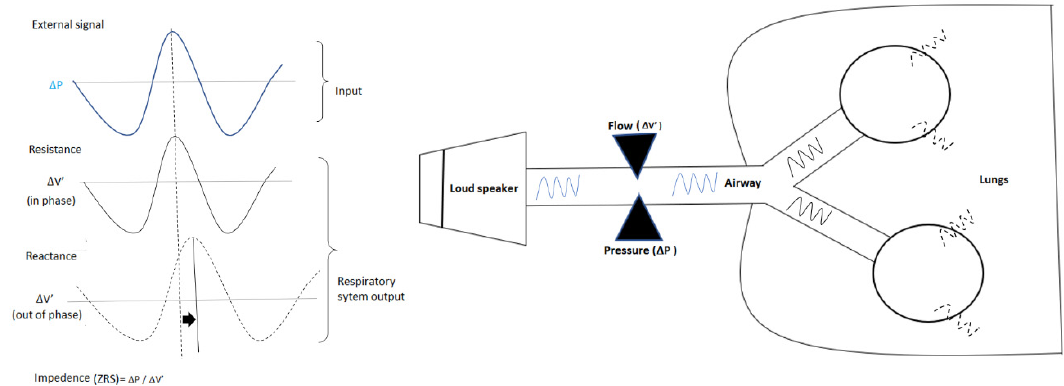
Figure 1. Schematic representation of input signal and output response by respiratory system in forced oscillation technique (FOT)